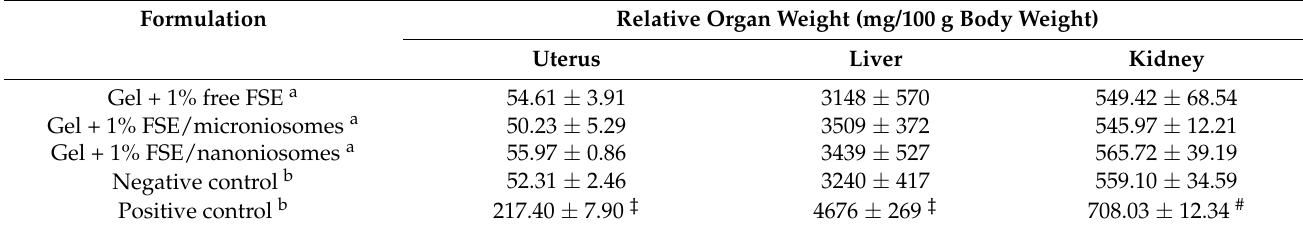
Table 2. Relative uterus, liver and kidney weights of rats treated by FSE microniosomes and nanoniosomes skin application after 84 days.